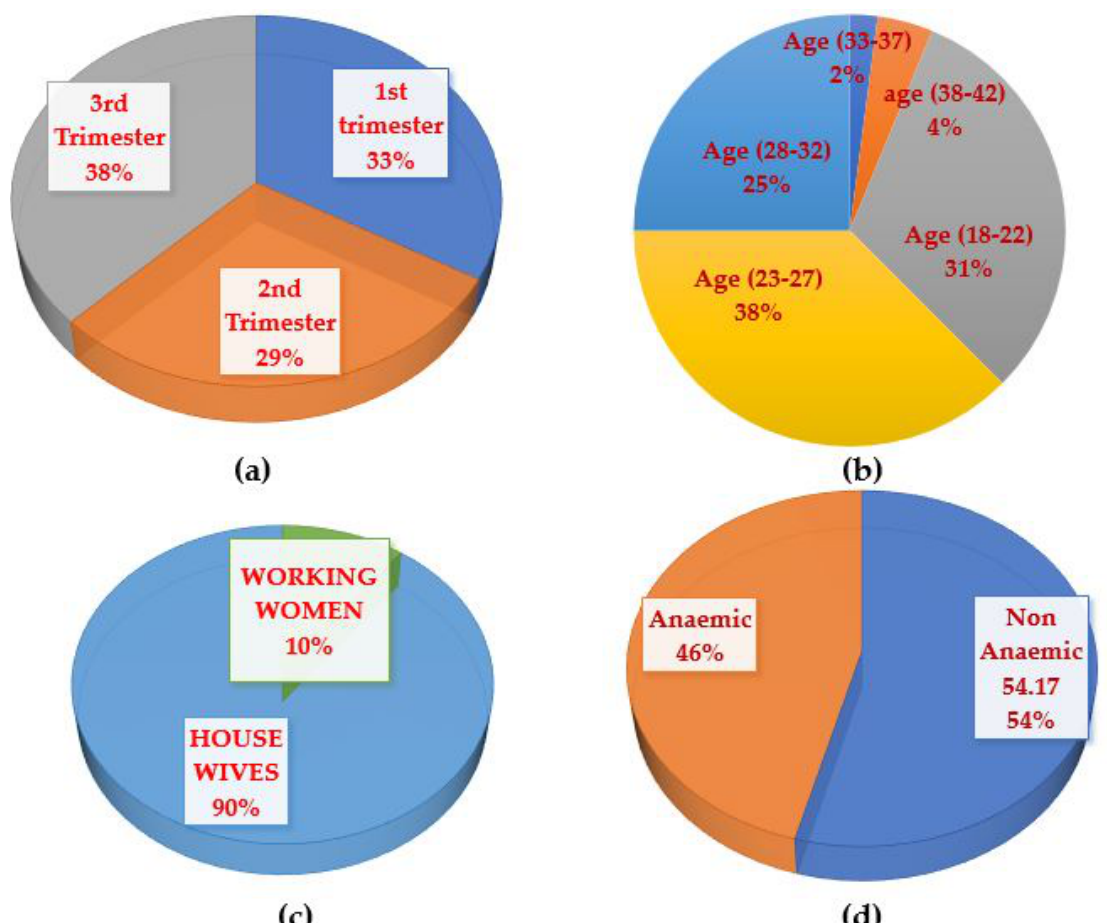
Figure 2. Maternal Patients Participants Distribution. ( a ) Trimester-based. ( b ) Age-based Distribution. ( c ) Profession-based. ( d ) Anemic and